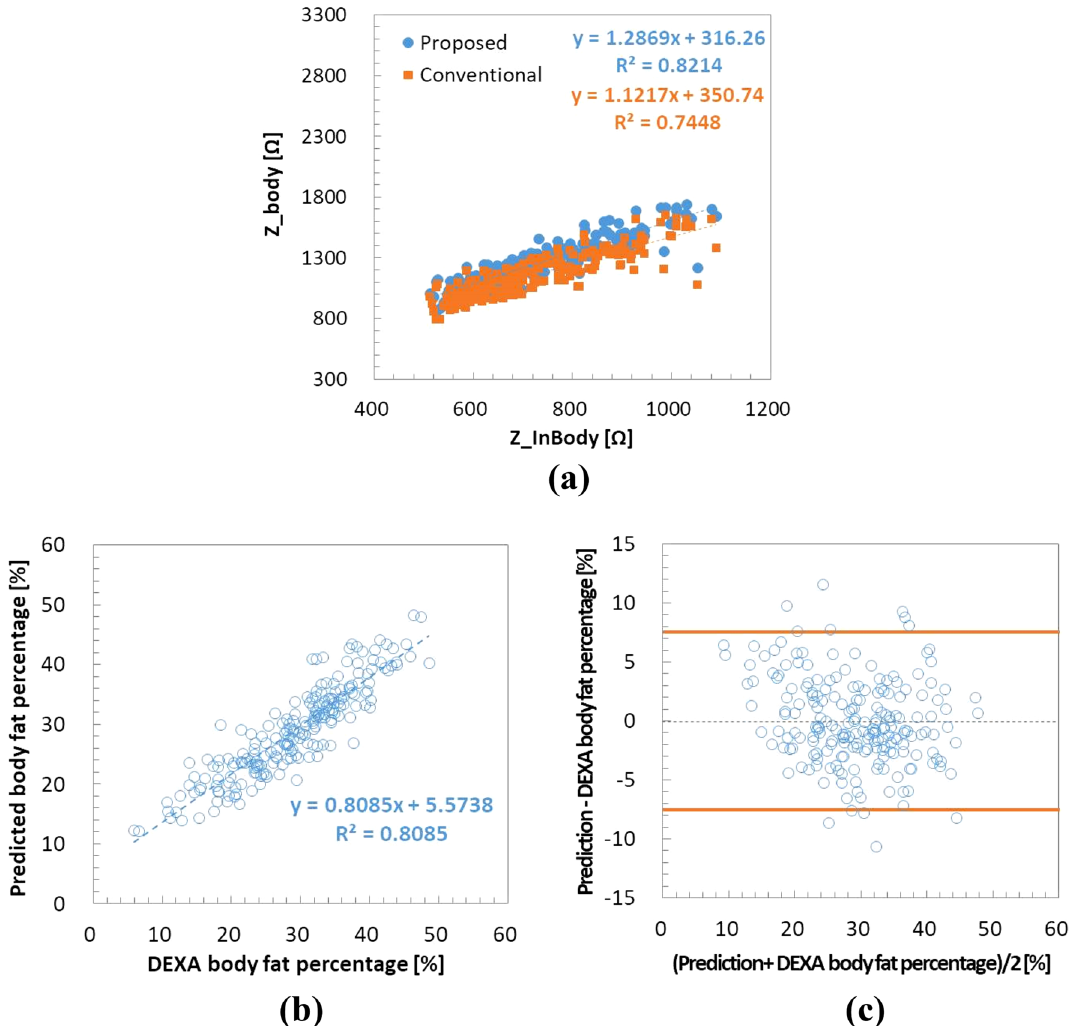
Figure 8. ( a ) Impedance correlation with contact resistance compensation (blue dots) and without contact resistance compensation (orange dots). Body fat algorithm accuracy (n = 203) assessment with ( b ) correlation plot and ( c ) Bland–Altman plot between our wrist-wearable bioelectrical impedance analyzer and the reference instrument (DEXA). DEXA dual-energy X-ray absorptiometry.